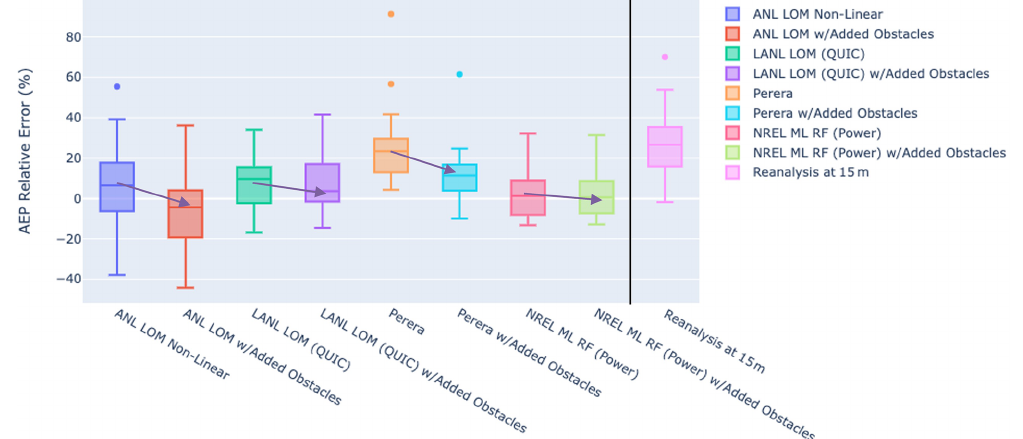
Figure 12. Box and whisker plots showing performance (median, IQR, 90th percentiles, and outliers) for the models studied, both with and without additional obstacles. The eight boxes on the left of the plot correspond to the models with and without additional obstacles, while the one on the right shows inflow without obstacle